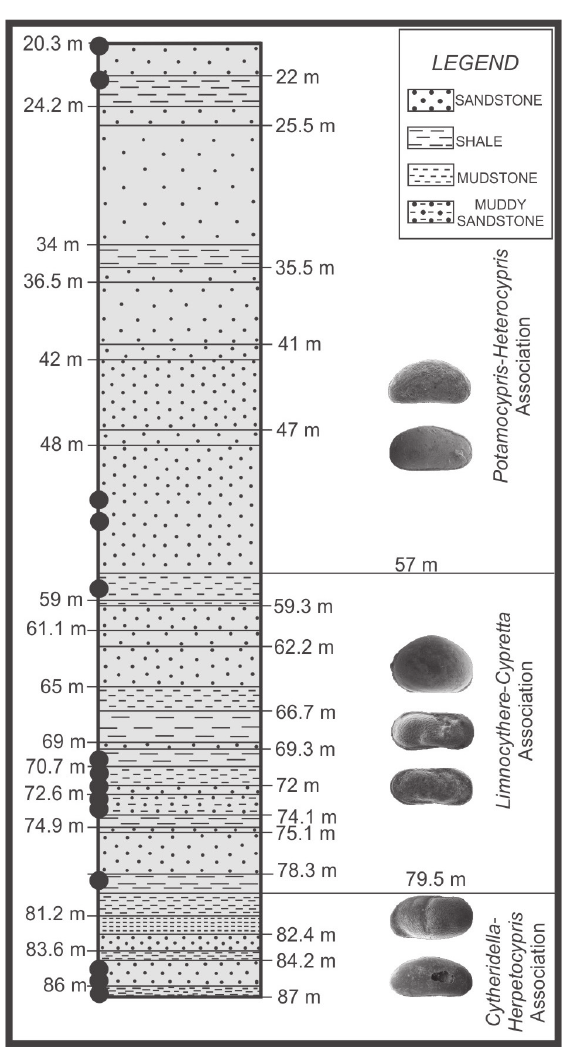
Figure 2 - Lithologic profile of the studied core and occurrence of the characteristic ostracod associations. Black dots indicate the sampling